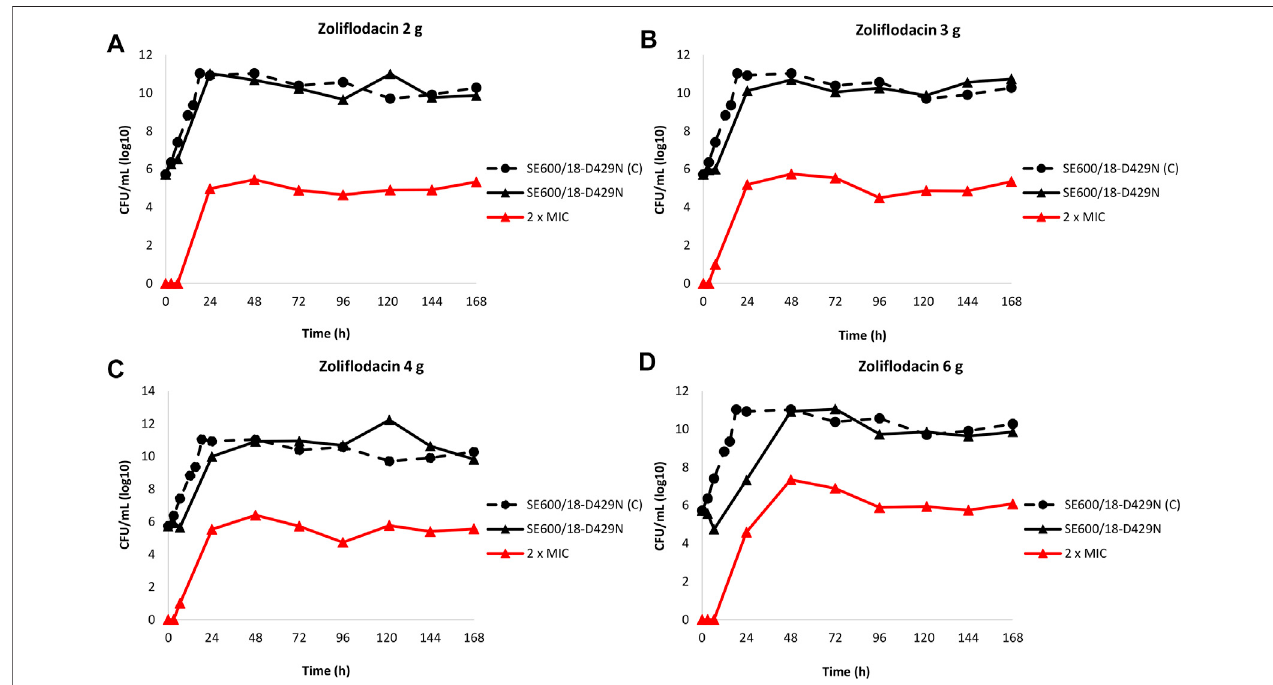
FIGURE2| Growthcurvesofthetotalpopulationofthezoli fl odacin-resistant Neisseriagonorrhoeae SE600/18-D429Nmutant(containingGyrBS467Naminoacid substitutionplusan invitro selectedD429Nsubstitution),inthedose-rangeHollowFiberInfectionModelexperimentsimulatingzoli fl odacinsingleoraldoseof2 (A) ,3 (B) , 4 (C) , and 6 g (D) and followed for 7 days are shown (black solid lines). The total growth of population with increased resistance (red lines) on the zoli fl odacin-containing plates (2 × MIC) and total growth of the untreated control (C; black dashed line) are also shown for each treatment.